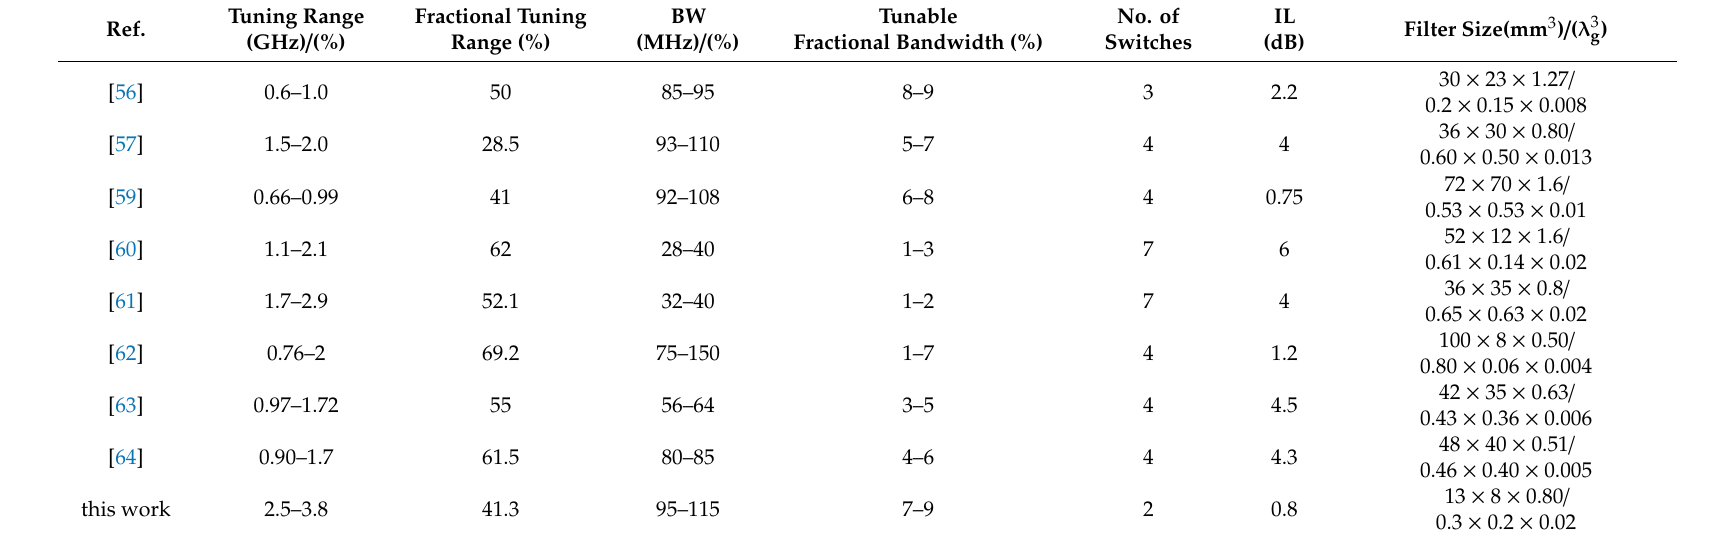
Table 1. Performance comparison with some other tunable